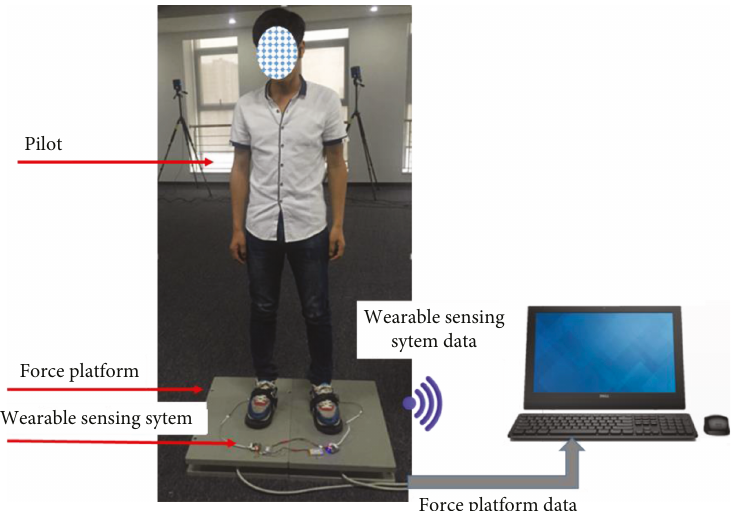
Figure 4: The setup of the stability test for a force measurement experiment.